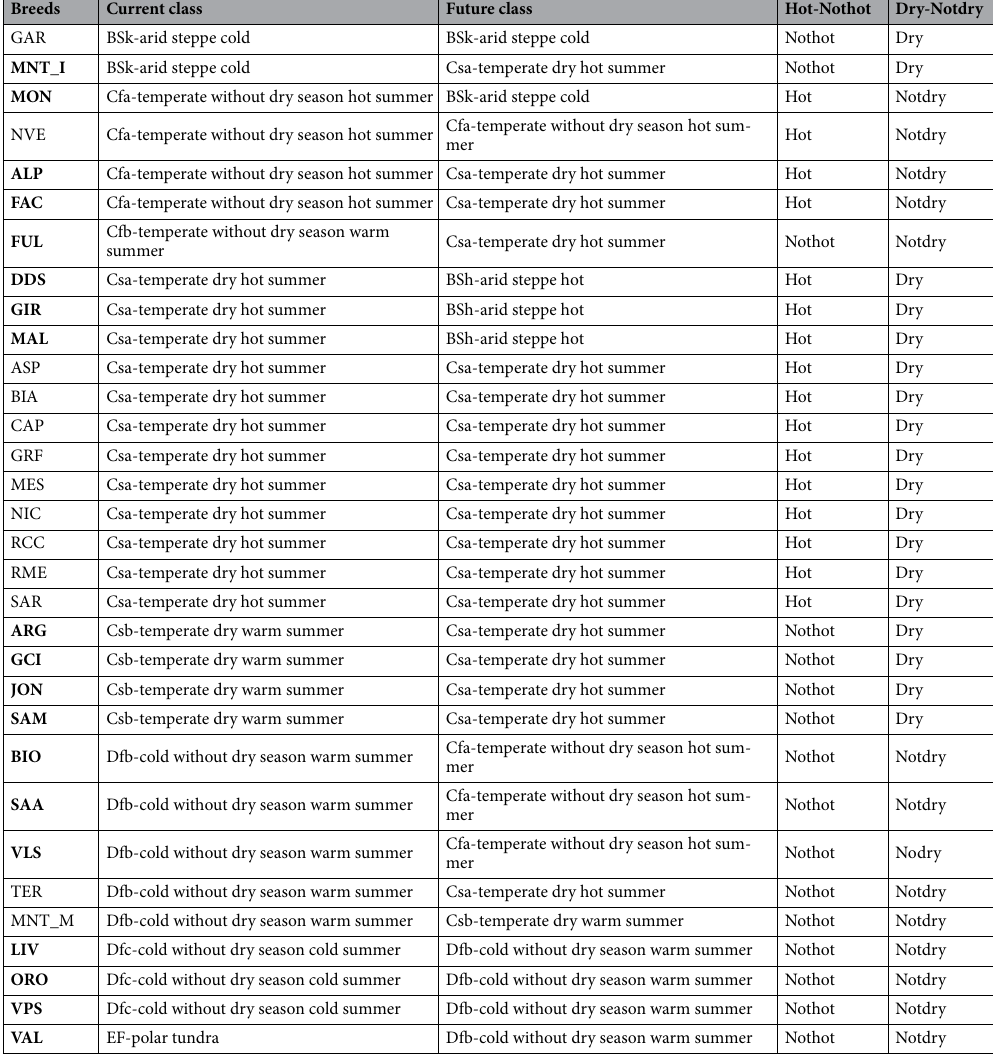
Table 2. Present and future predicted Koppen-climate class and Anova classification for breed divided in the two groups: HOT/NOTHOT and DRY/NOTDRY (see Materials and Methods). In bold those breeds that will change their Koppen classification in the next 70